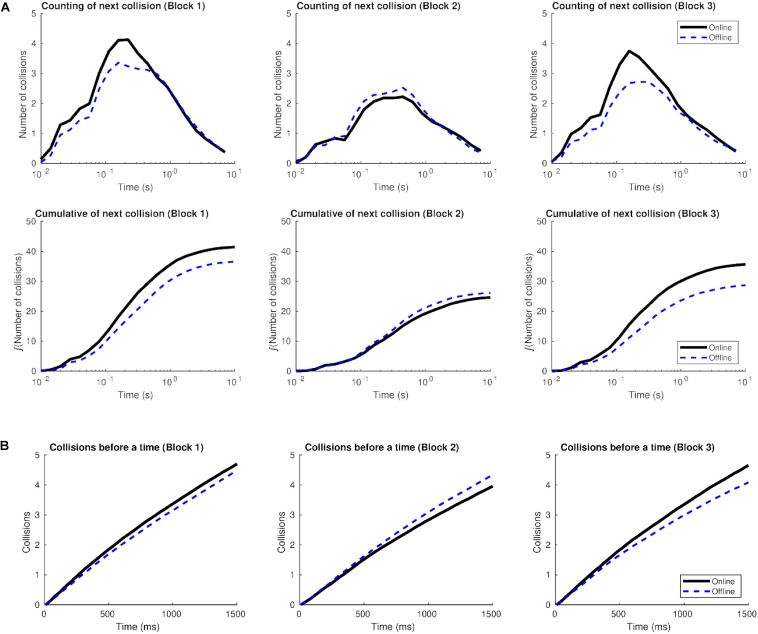
Distribution of the number of crossings according to the window span in Study 2. (A) The distribution has a Gaussian shape. The x-axis (time) is shown on a logarithmic scale in order to see the relation between short times (milliseconds) and longer ones (dozens of seconds, which is the length of a round). At the top: number of crossings after one crossing of reference in relation to the time they are produced, for each block and type of agent. At the bottom: the number of accumulated crossings as a function of time. (B) Distribution of the number of crossings as we increase the window span. The graphs show how many crossings are produced in the window span from one crossing until a specific amount of time.